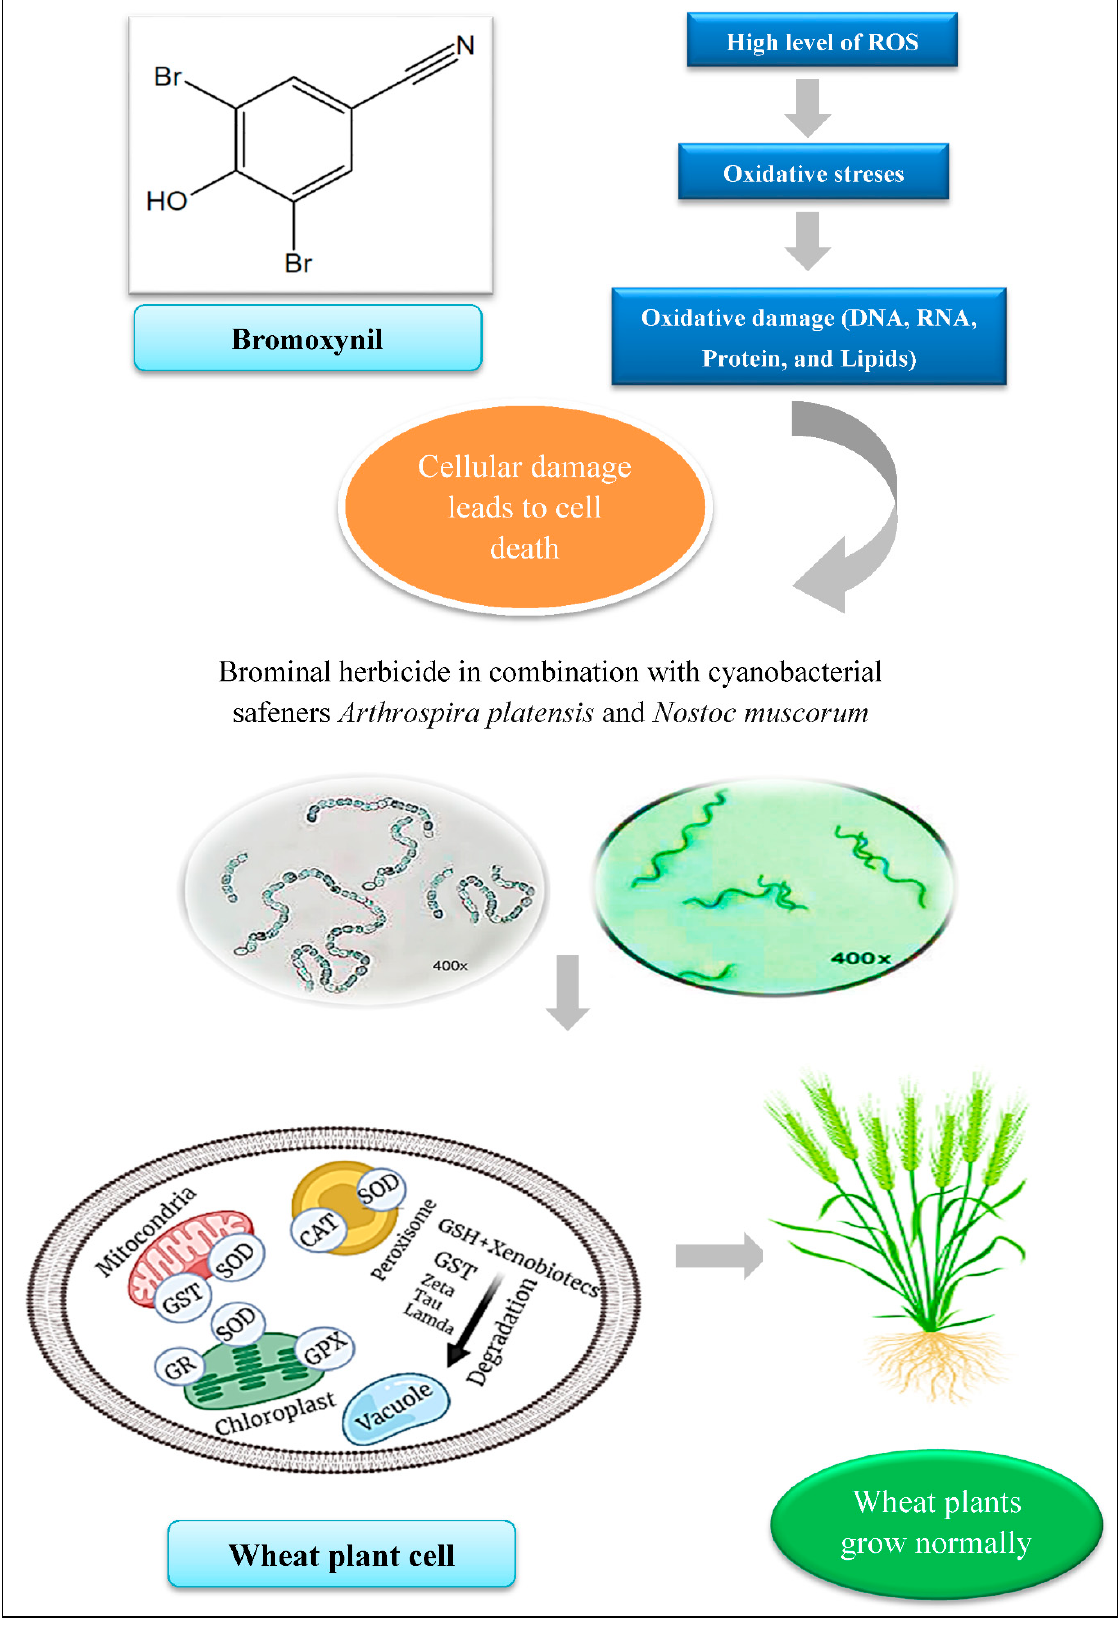
Figure 6. A schematic representation of the effect of cyanobacterial extract safeners against the herbicide’s harmful effect on wheat plants.